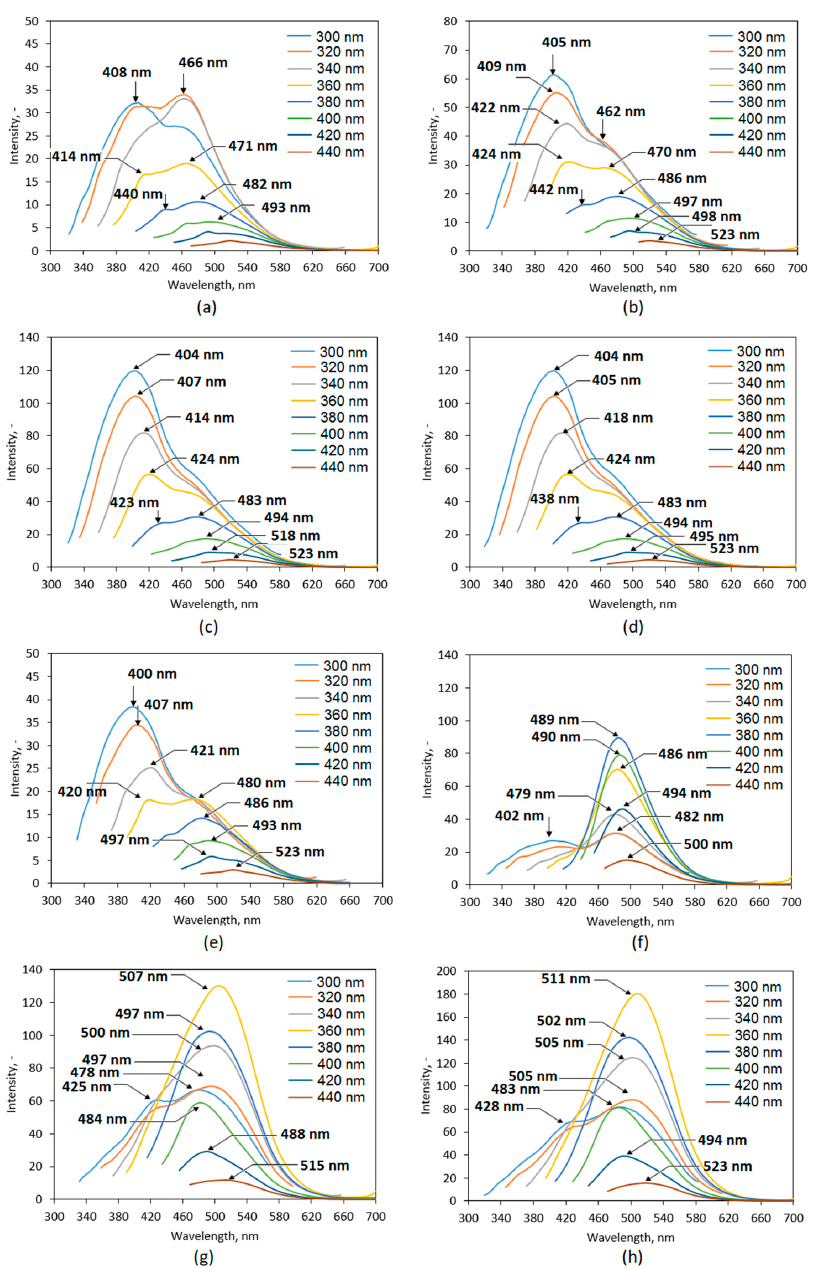
Figure 8. Fluorescence spectra of the prepared CQDs: ( a ) CQDs-1; ( b ) CQDs-2; ( c ) CQDs-3; ( d ) CQDs-4; ( e ) CQDs-5; ( f ) CQDs-6; ( g ) CQDs-7; ( h ) CQDs-8. Table 1. Coumarin-modified CQD quantum yield and its stability in time (7 and 30 days). Sample Fluorescence Quantum Yield, % Photostability after 7 Days,